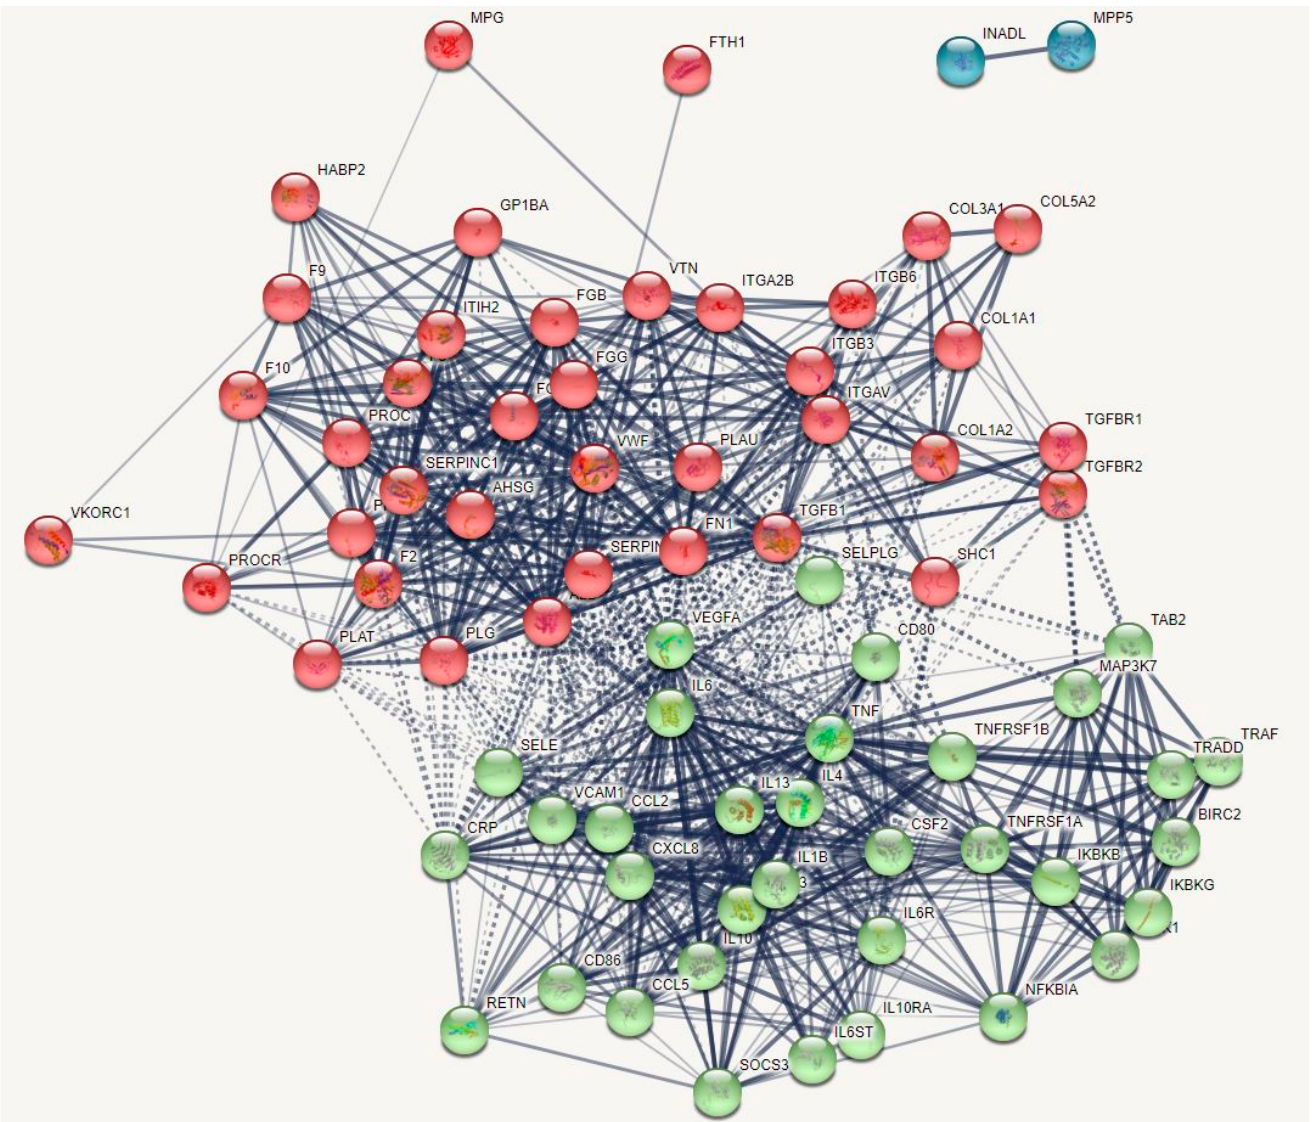
Figure 7. First-order protein network showing the results of Markov Clustering (MCL) analysis with (1) a first hemostasis fibrin-clot cluster (red bullet icons); and (2) a second immune cluster (green bullet icons). Blue bullets: not belonging to any cluster.